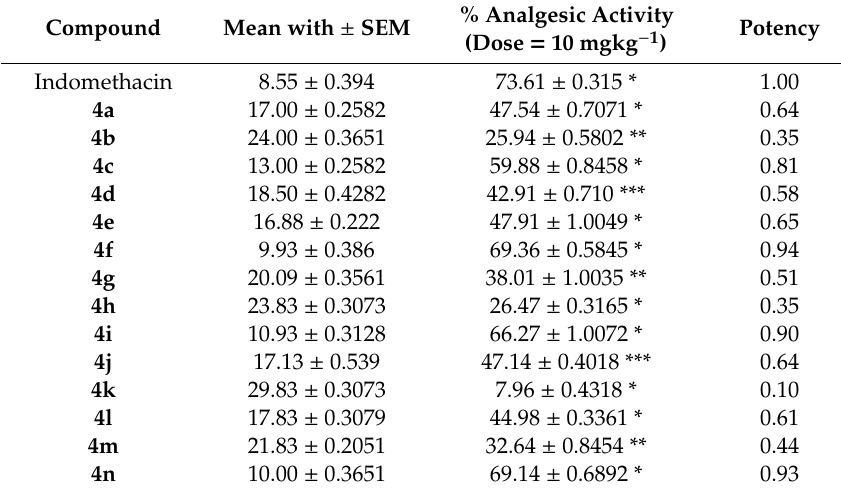
Table 2. Analgesic activity of 1-(substituted phenyl amino